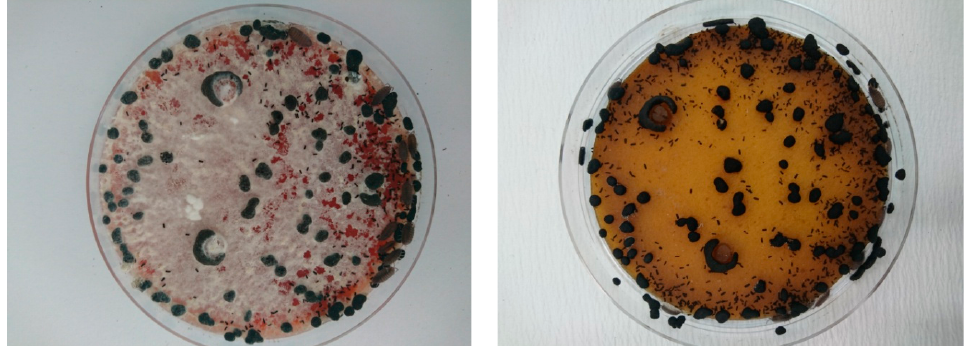
Figure 4. Sclerotinia sclerotiorum mycelial loss in two weeks (Photo: Nóra Balázs, Gödöll ő , Hungary, 2016).